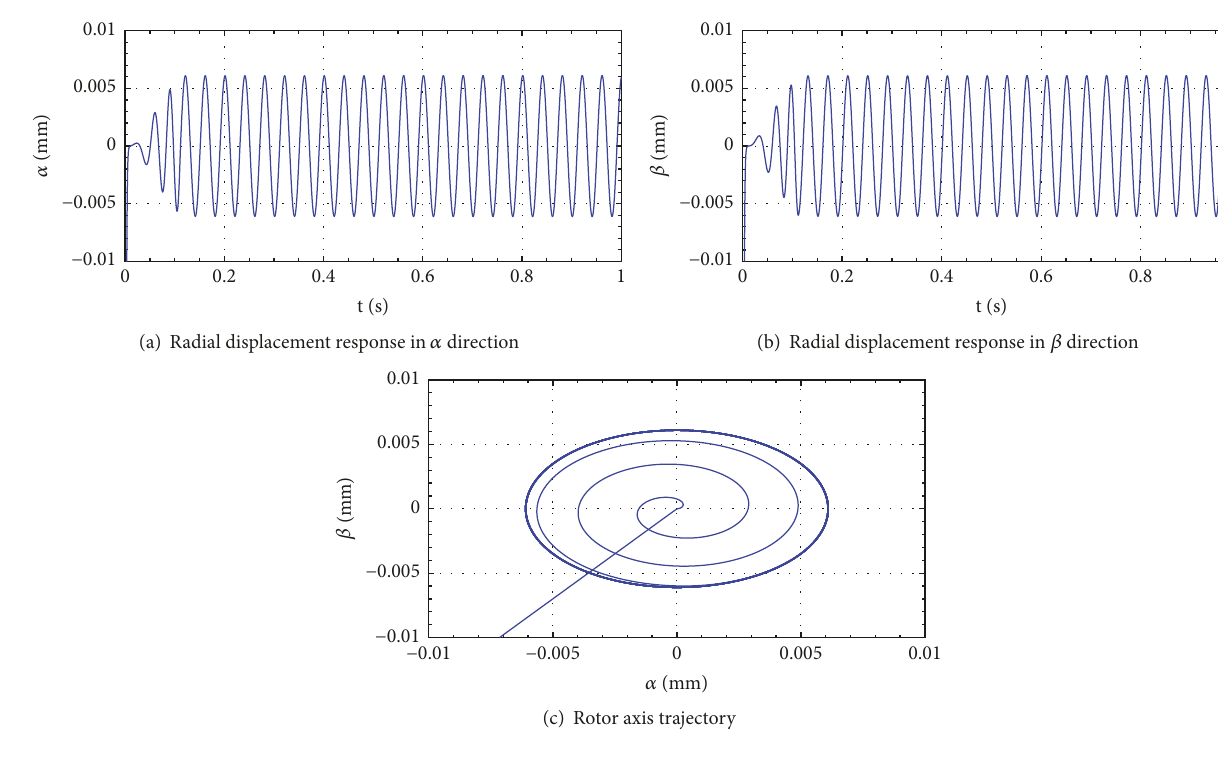
Figure 6: Displacement curve before vibration compensation.